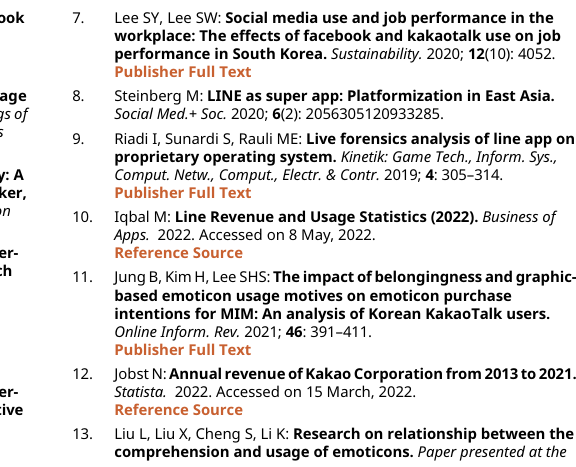
(cid:129) Paid Sticker Article Datasets.xls. (Anonymised raw data responses to the survey).